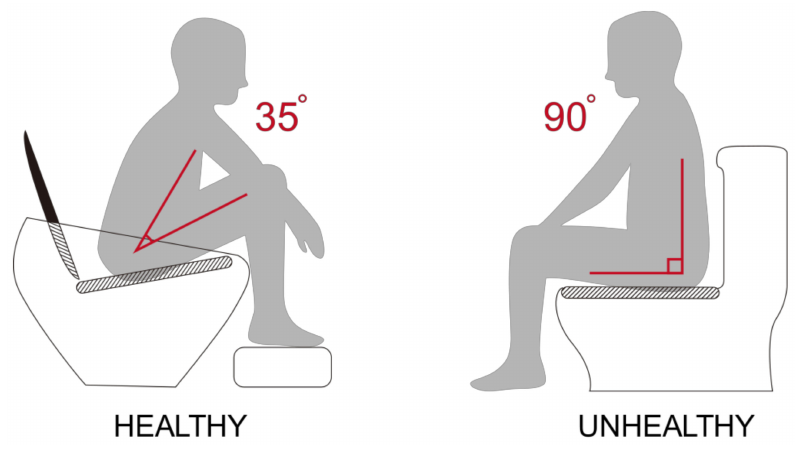
Figure 5. The proper posture and angle to relax a human’s intestines.